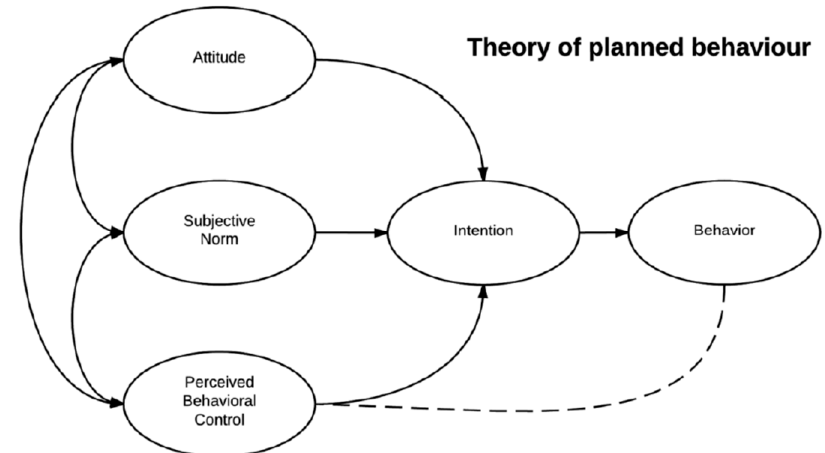
Figure 1. The Construct of Theory of Planned Behavior (adapted from [14] by Robert Orzanna).